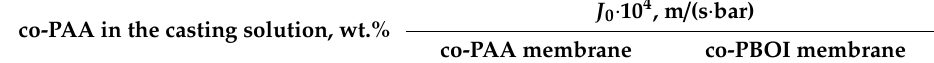
Table 4. The e ff ect of the polymer (co-PAA) concentration in the casting solution on pure water flux ( J 0 ) through membranes. co-PAA in the casting solution,